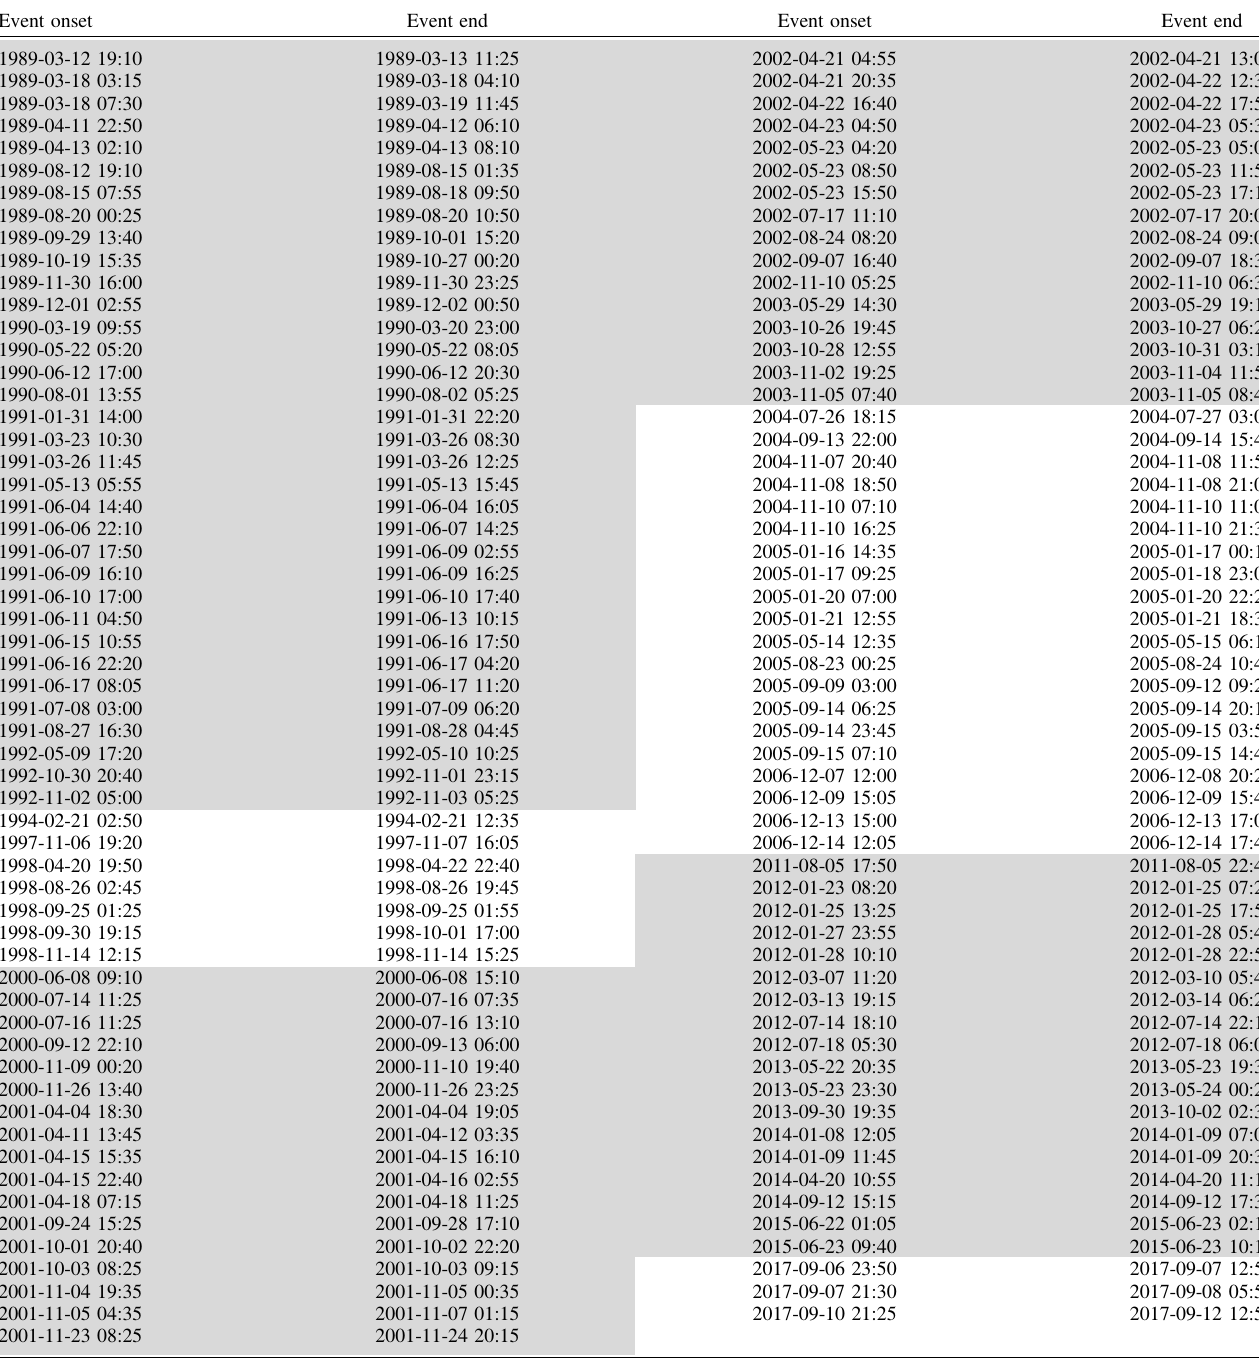
Table A.1. List of events where the maximum global polar cap absorption was >2 dB at 30 MHz. Event onset and end are indicated in YYYY – MM – DD HH:MM format. Data were evaluated at 5-min increments. Grey shading indicates events observed during solar maximum years, similar to Figure